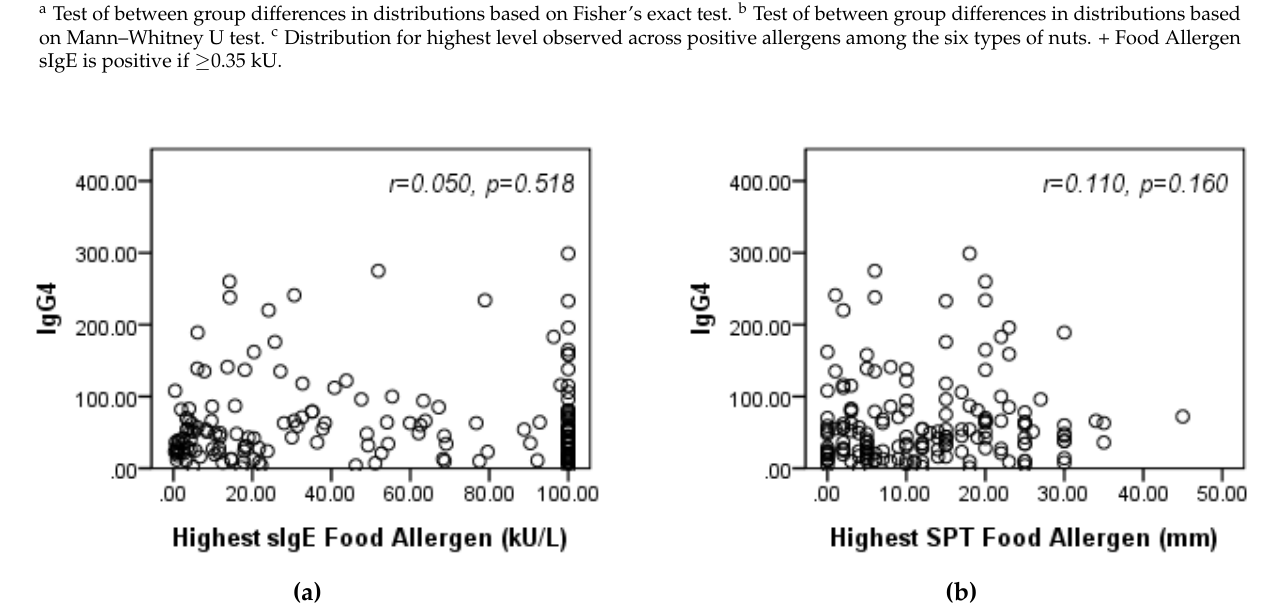
Figure 1. Scatterplots display highest sIgE ( a ) and skin prick test (SPT) ( b ) in patients with at least one positive food allergen (sIgE ≥ 0.35 kU/L) against immune response parameter IgG4 ( r = Spearman’s correlation coefficients), n = 167. Table 3. Six common peanut and nut allergen parameters described in relation to positive SARS-CoV-2 status ( n = 170 with allergen test results).